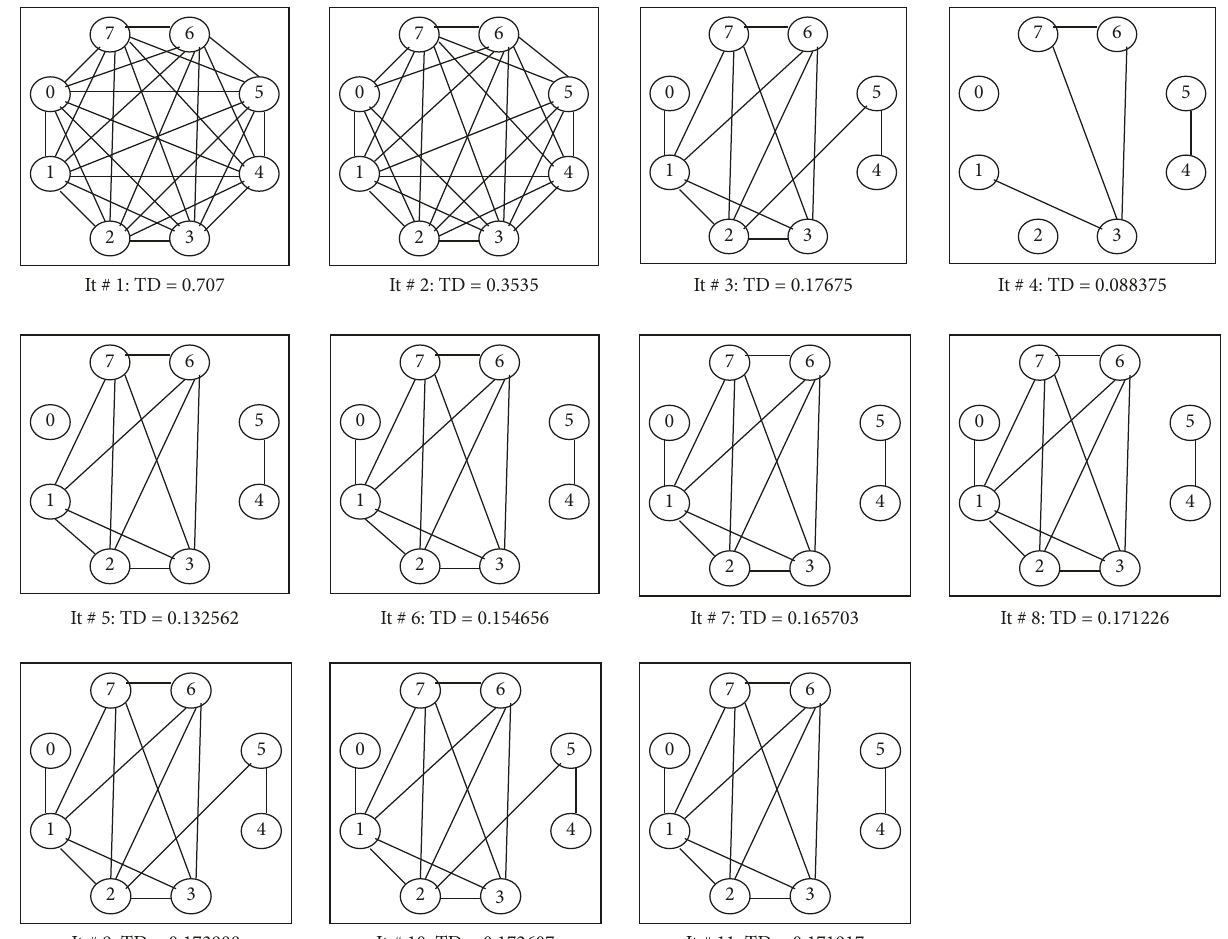
Figure 4: Unit disk graphs constructed during the iterations of the binary search algorithm for the example graph of Figures 1 and 2 and the normalized coordinate system of (DEG,